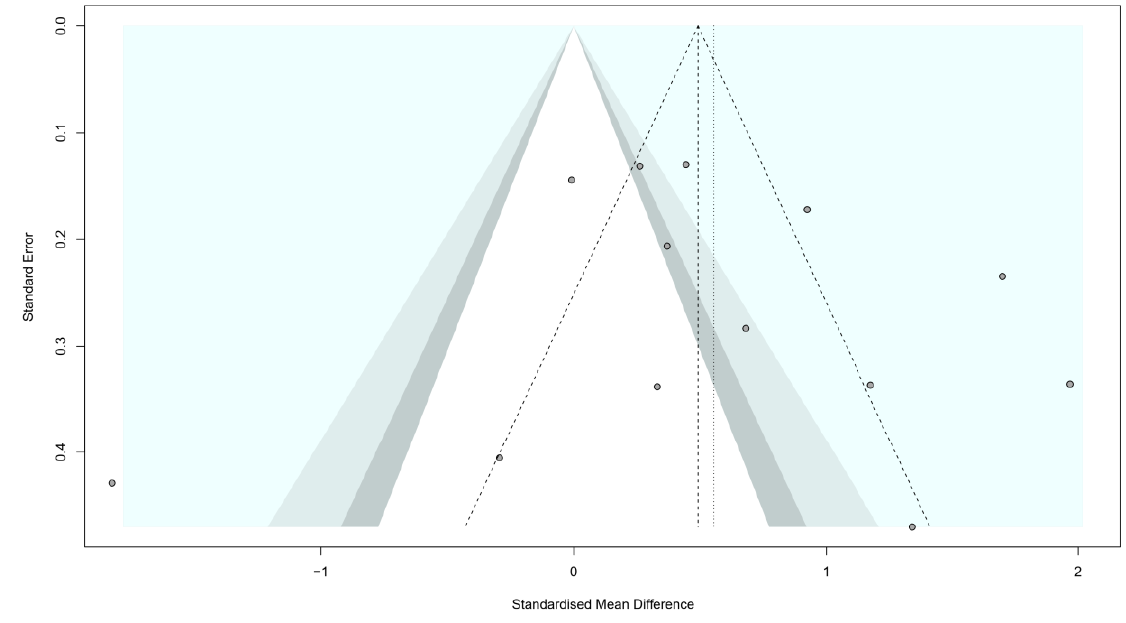
Figure 3. Funnel plot for reporting bias assessment.